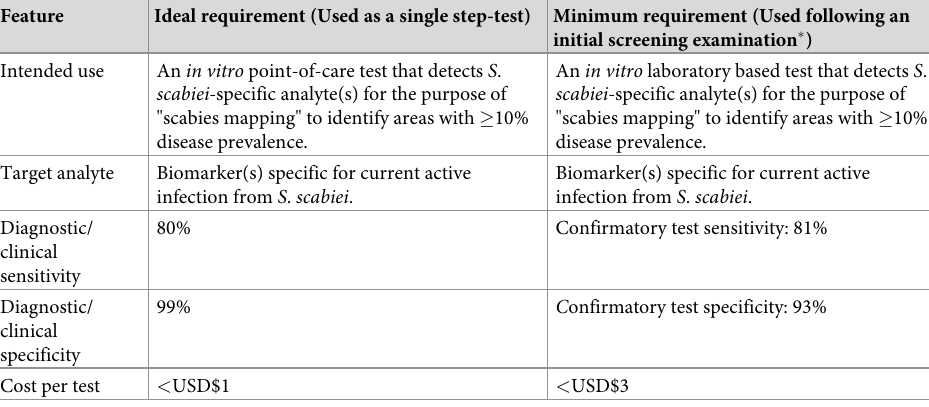
Table 3. Select characteristics of needed test for Stopping